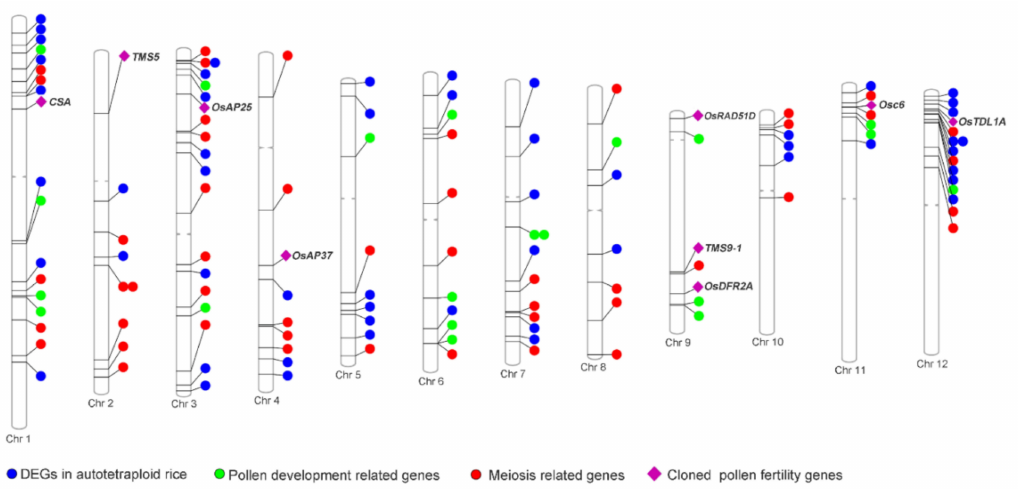
Figure 6. The distribution of up-regulated genes involved in meiosis and pollen development in H1 compared with its two parents. DEGs in autotetraploid rice indicated the DEGs detected in the pollen development process of autotetraploid rice; Pollen fertility genes indicated the DEGs involved in the pollen development process; Meiosis-related genes indicated the DEGs involved in meiosis; Cloned pollen fertility genes indicated the known pollen fertility